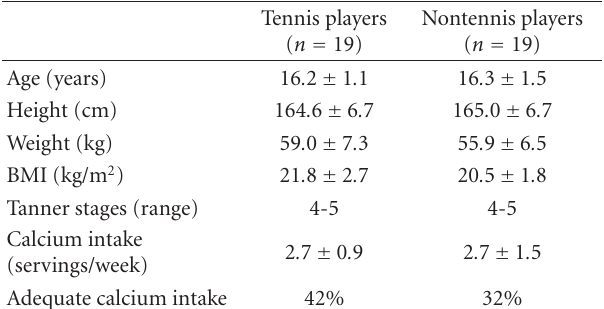
Table 1: Characteristics of